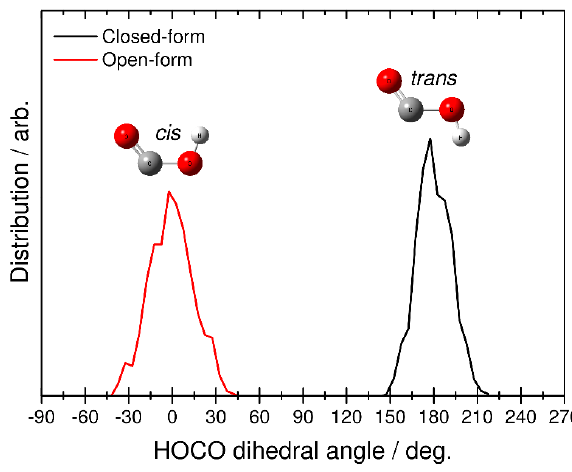
Figure 7. Distributions for the final HOCO dissociation product plotted as a function of the H-O- C-O dihedral angle obtained from the RPMD calculations. Black and red solid lines correspond to the RPMD results obtained from initial closed- and open-form C 2 O 4 H − , respectively.